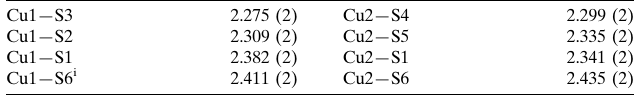
Key indicators: single-crystal X-ray study; T = 298 K; mean (cid:1) (C–C) = 0.016 A˚; R factor = 0.034; wR factor = 0.078; data-to-parameter ratio = 17.7.